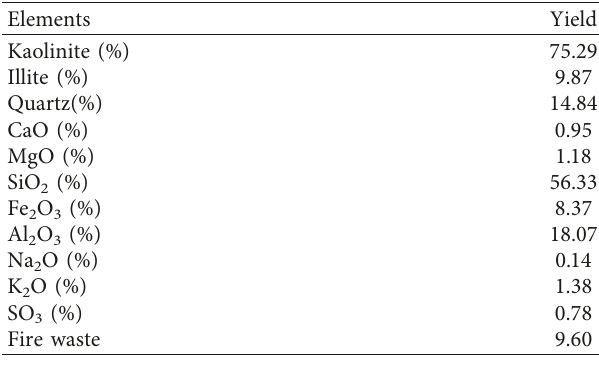
Table 1: Characteristics of raw Sejnane